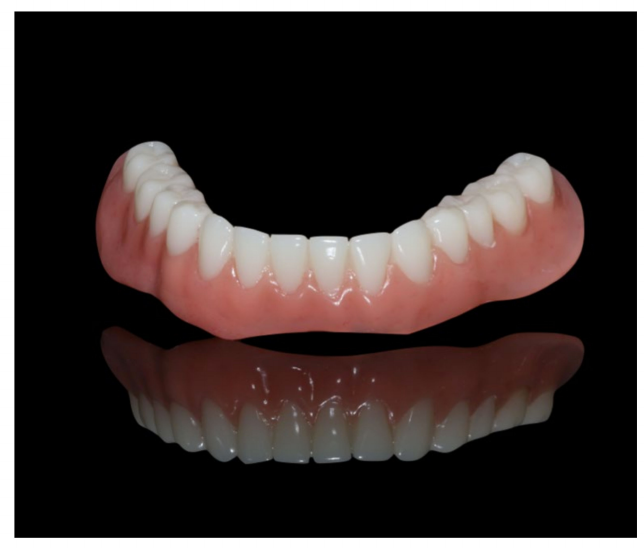
Figure 16. Polished implant-supported overdenture in the lower jaw ready for insertion.